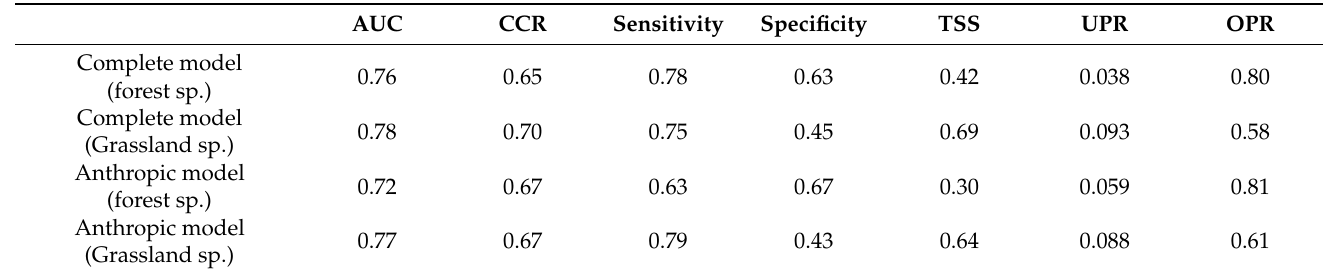
Sensitivity; Specificity; Under Prediction Rate (UPR) and Over Prediction Rate (OPR).